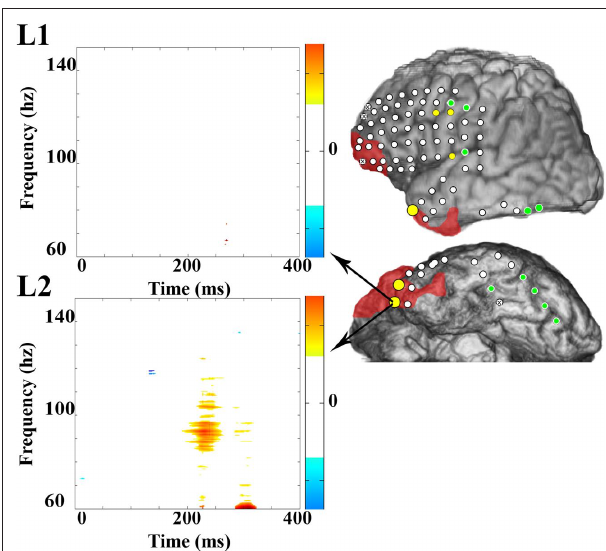
FiGuRE 3 | Electrocorticographic spectral mapping of visual object naming in L1 and L2 in Patient 3b. Electrode color schemes are the same as in Figure 2 . HGA( + ) electrodes that were over regions that were ultimately resected are enlarged for emphasis. Time–frequency plots of changes in power obtained with MP analysis are shown for one selected anterior temporal electrode that was HGA( − ) for L1 (top) and HGA( + ) for L2 (bottom) and was over a region that was ultimately resected. Time zero on the X -axis is the time of stimulus onset. On the color spectrum depicted to the right of each plot, red to yellow indicates a significant increase in magnitude of power after stimulus-onset relative to the baseline within a given time (in ms)–frequency (in Hz) range, and the spectrum from light to dark blue indicates a significant decrease in power. White indicates no significant difference.